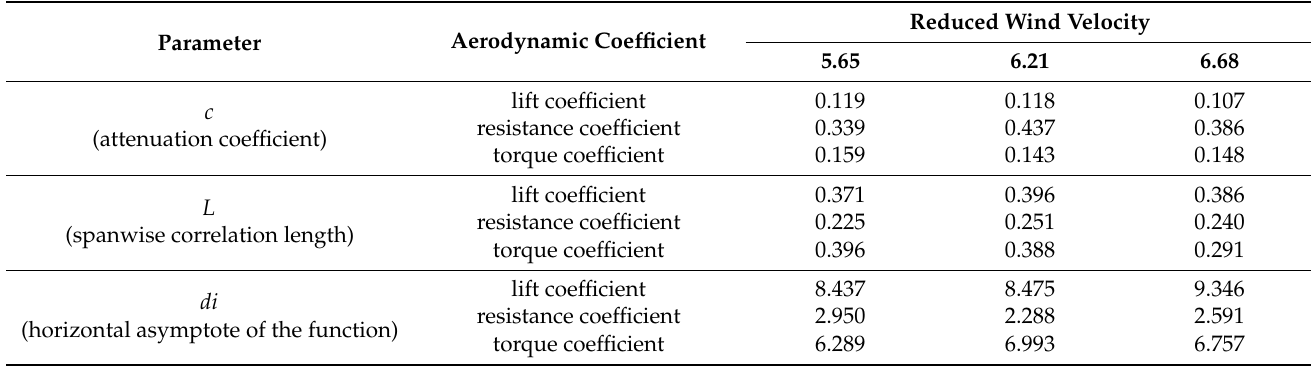
Table 5. Fitting value of aerodynamic spanwise correlation coefficient parameters and spanwise correlation length of the main beam in the vibrational